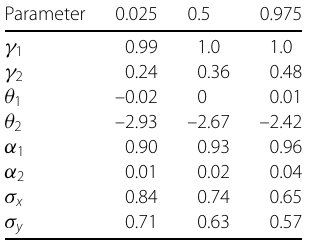
Table 2 Overview of 95% posterior intervals of the DCRWS parameter estimates Parameter